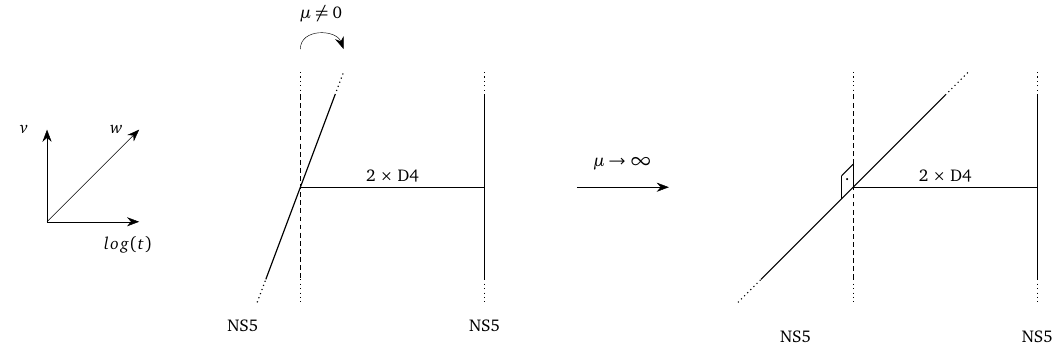
Figure 2: Rotation of the branes in the Hanany-Witten setup, which results in break- ing N = 2 to N = 1 supersymmetry. Again we show the construction for su ( 2 ) pure